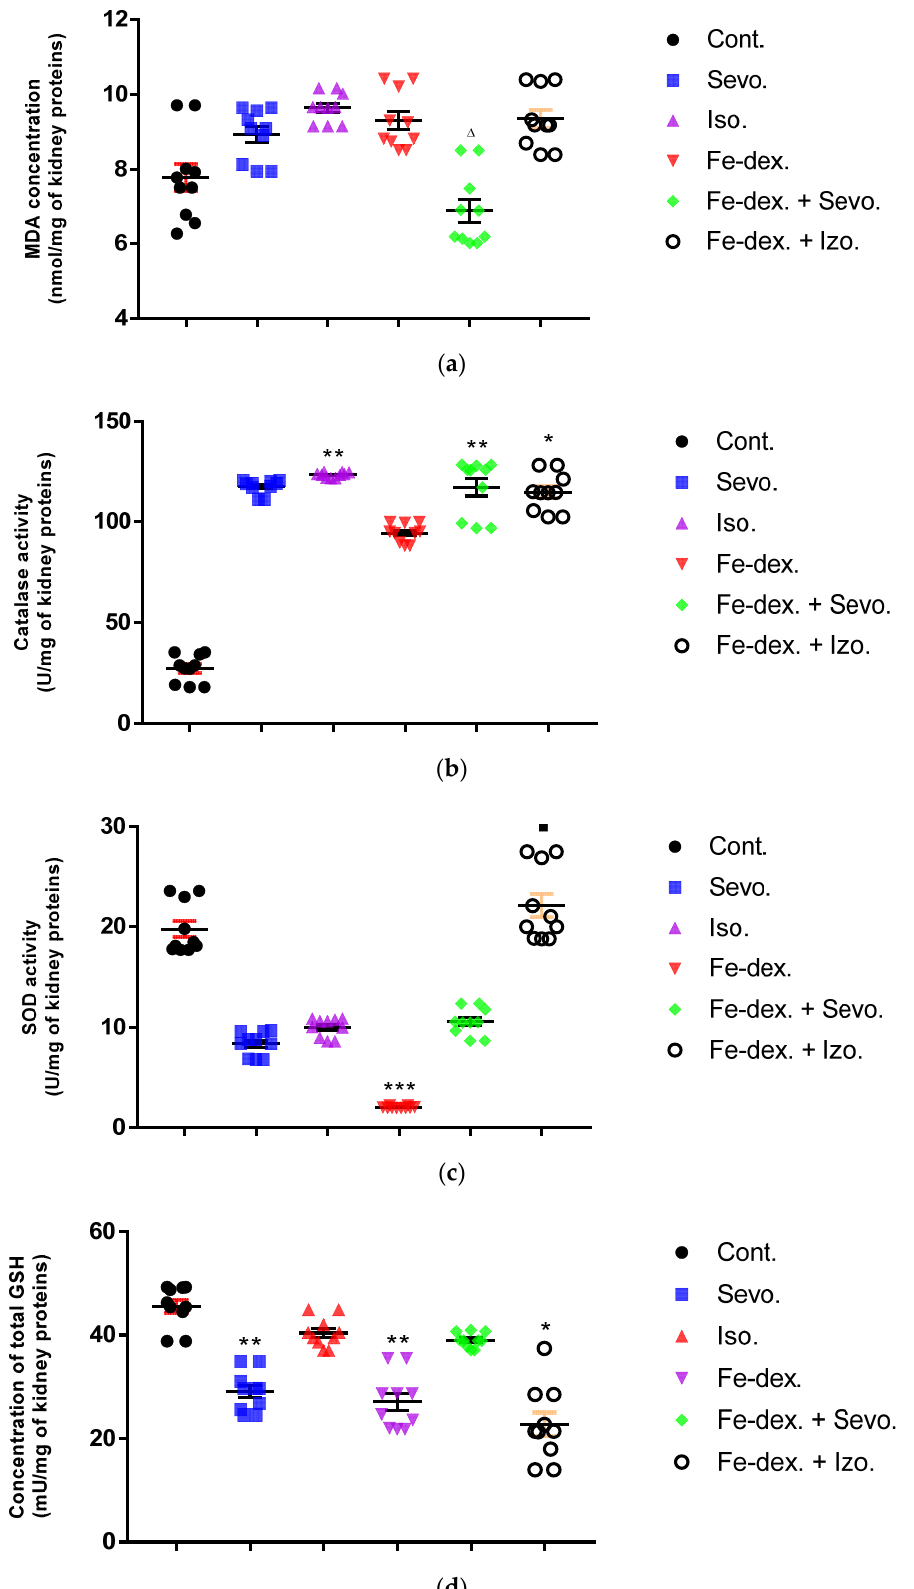
Figure 9. Effect of inhaled anesthetics and iron dextran on MDA ( a ), CAT activity ( b ), SOD activity ( c ), and GSH ( d ) in the kidney of rats treated for 28 days. Rats ( n = 10 per group) were treated with ip injection of iron dextran (50 mg/kg), exposed to 2.4 vol % sevoflurane inhalation and 1.3 vol %